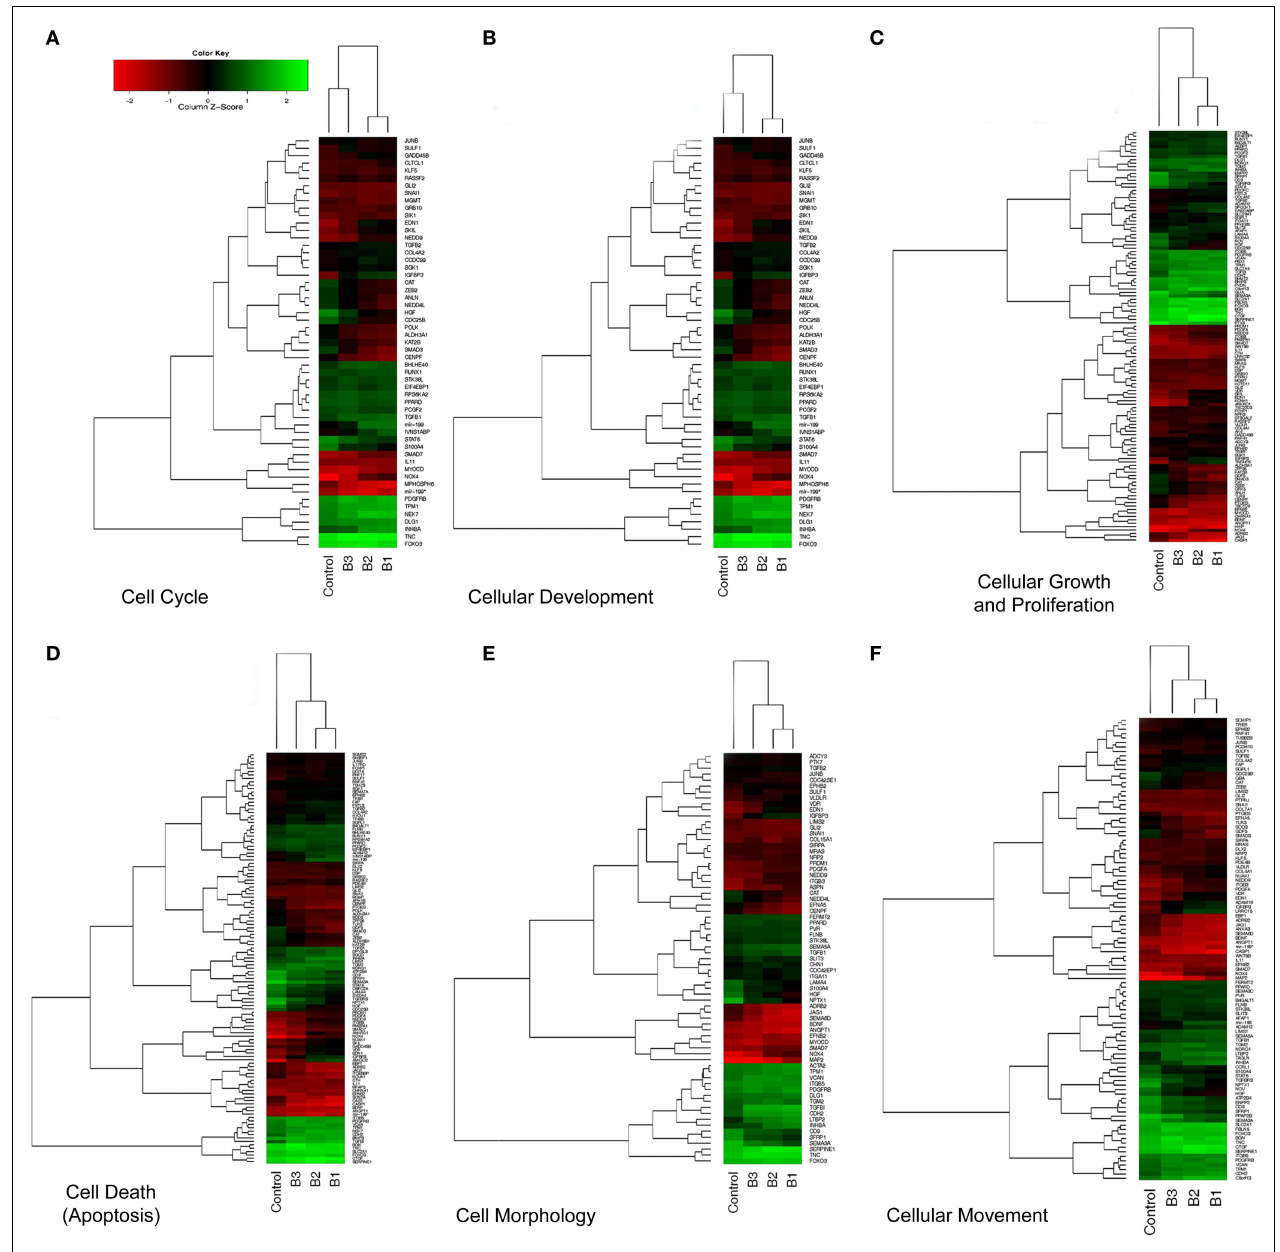
(eitherTGF β or Control) in triplicate, and each row corresponds to a transcript. The increasing intensities of red signify a higher expression in the given sample of a specific mRNA, whereas the increasing intensities of green indicate a lower expression of mRNA and black indicates mean level expression.The list of genes for each particular function (A–F) was shown in Table 1 .